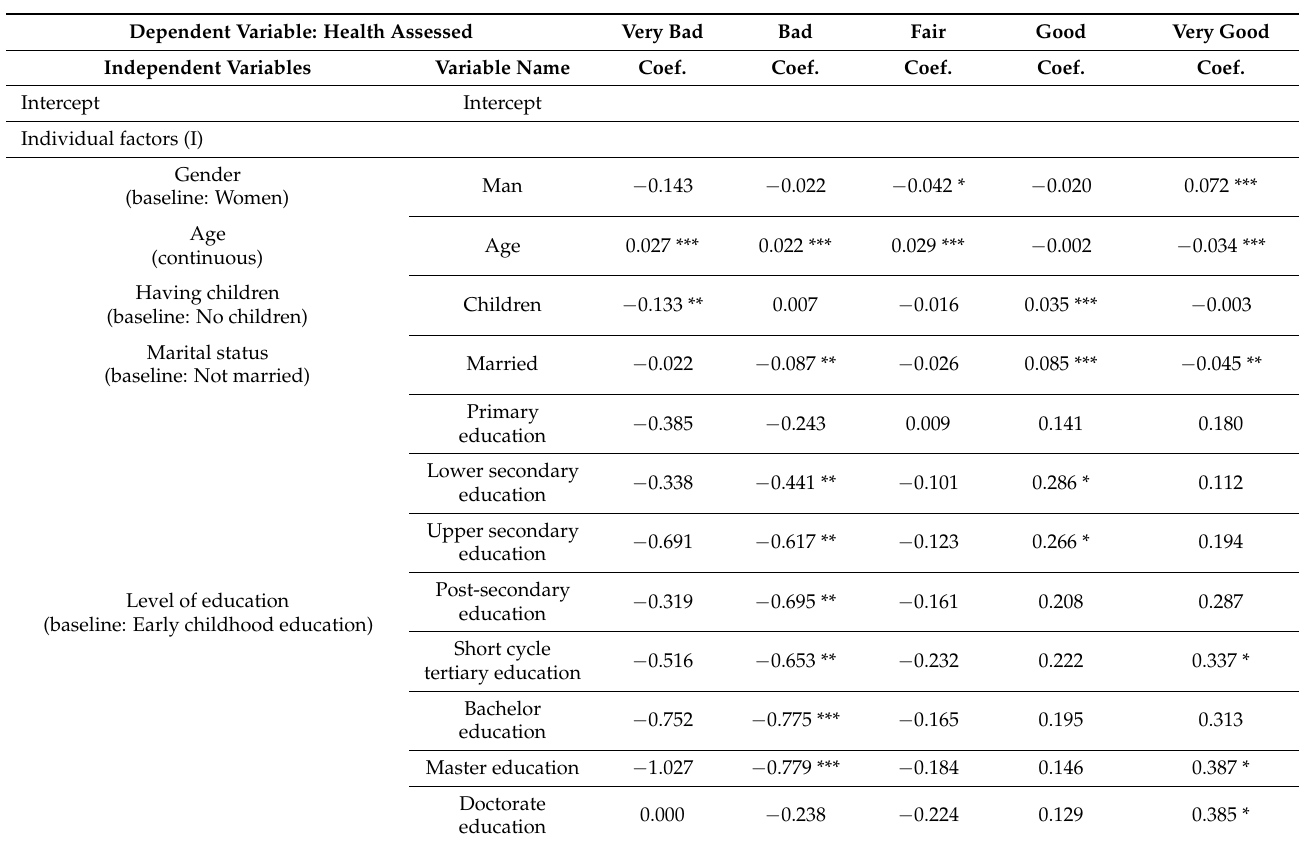
Table 4. Probit regression results for the countries’ differences